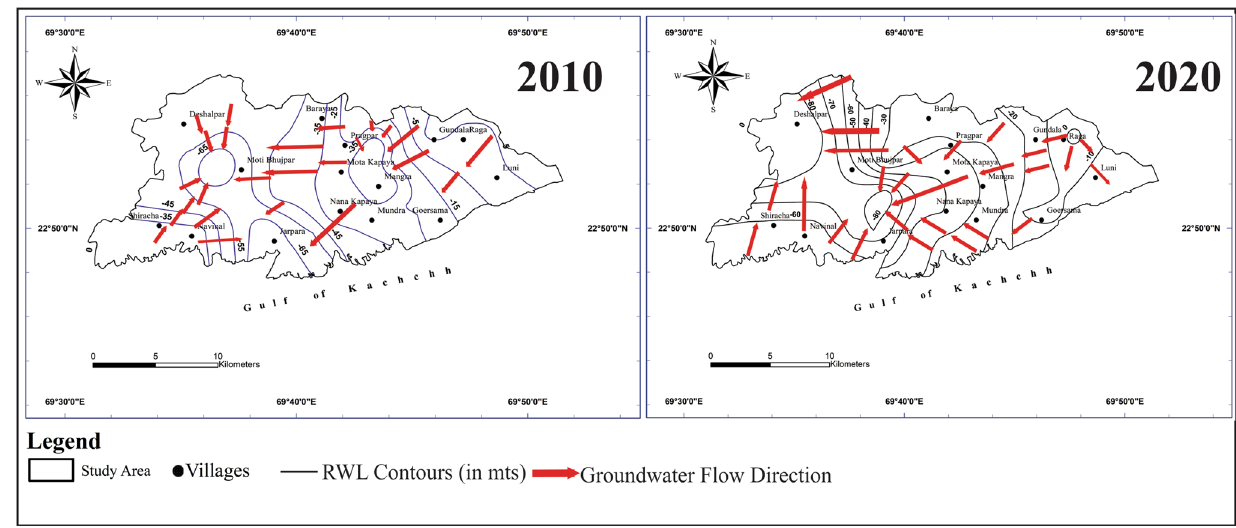
Fig. 9 Reduced water level (RWL) map showing groundwater flow directions for 2010 and